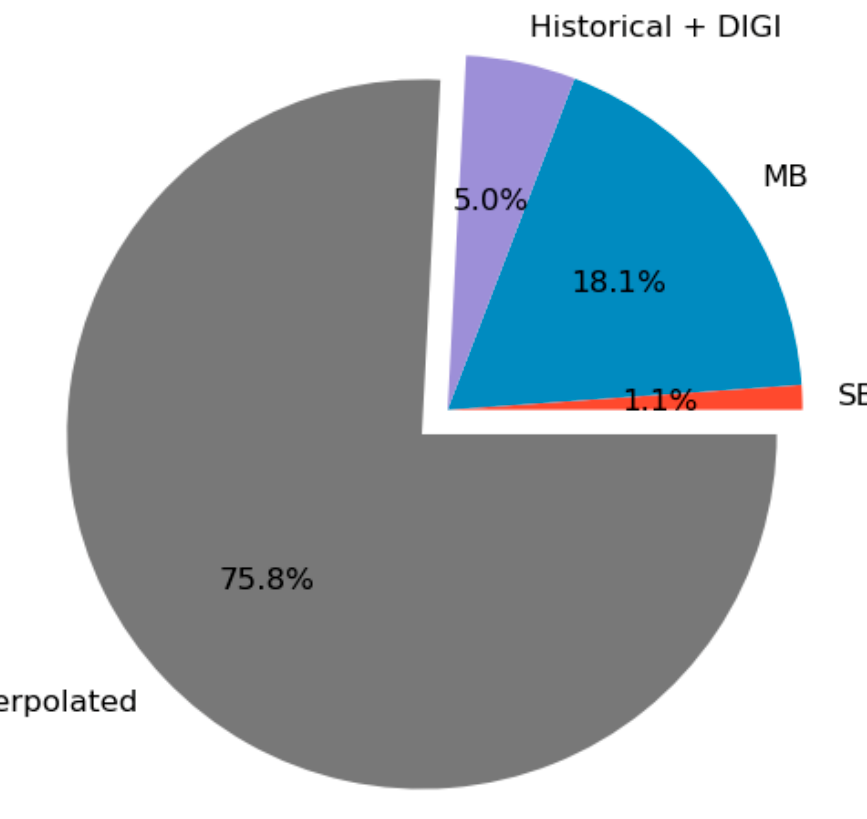
Figure 6. Percentage distribution of the different source types. The labels follow the convention described in Table 1 for ddm_50m.kilde.